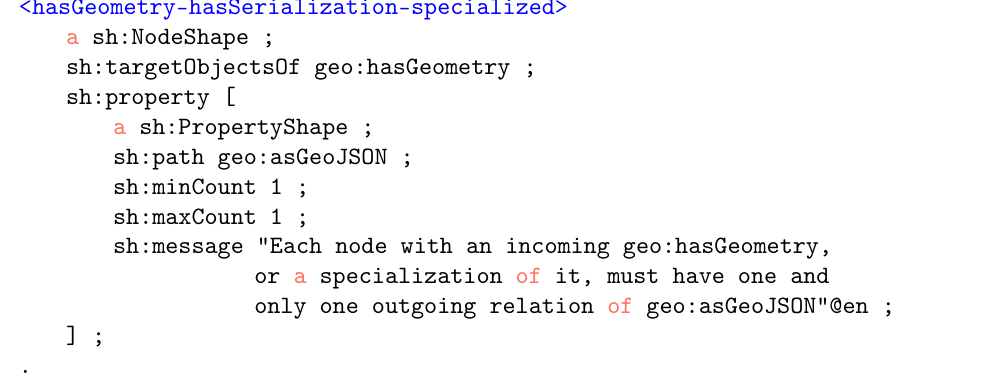
Figure 6. Requirements vocabulary applied to benchmark results of the GeoSPARQL compliance benchmark applied in the HOBBIT platform. Benchmark results can be mapped to RDF concepts representing requirements and conformance classes of the to-be-tested specification. Listing 12. An custom GeoSPARQL Feature validator ensuring all Features have only one GeoJSON geometry